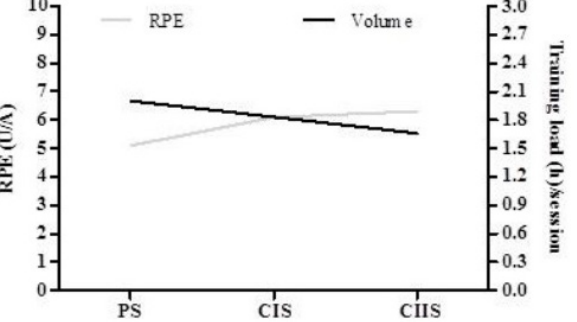
Figure 1. Training load (h) and ratings of perceived exertion (U/A) during the stages of periodization.